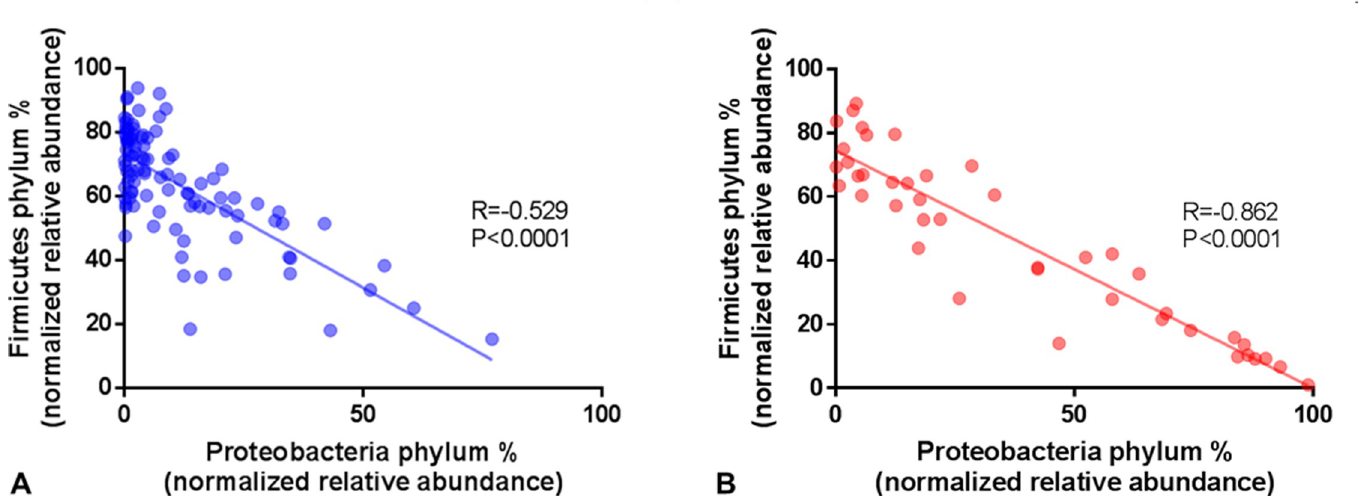
Fig 4. Correlation of the phyla Proteobacteria and Firmicutes in DA from (A) non-SIBO (N = 98) and (B) SIBO (N = 42) subjects.